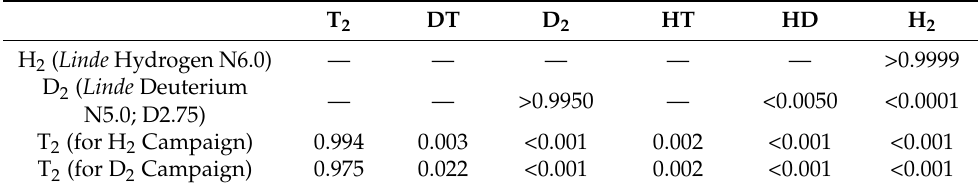
Table 3. Purities of the primary gases H 2 , D 2 , and T 2 used in the various mixing campaigns. Note that the T 2 batch composition, provided by the ISS of TLK, differed from campaign to campaign, but was nearly stable (change < 0.1%) for the duration of any individual